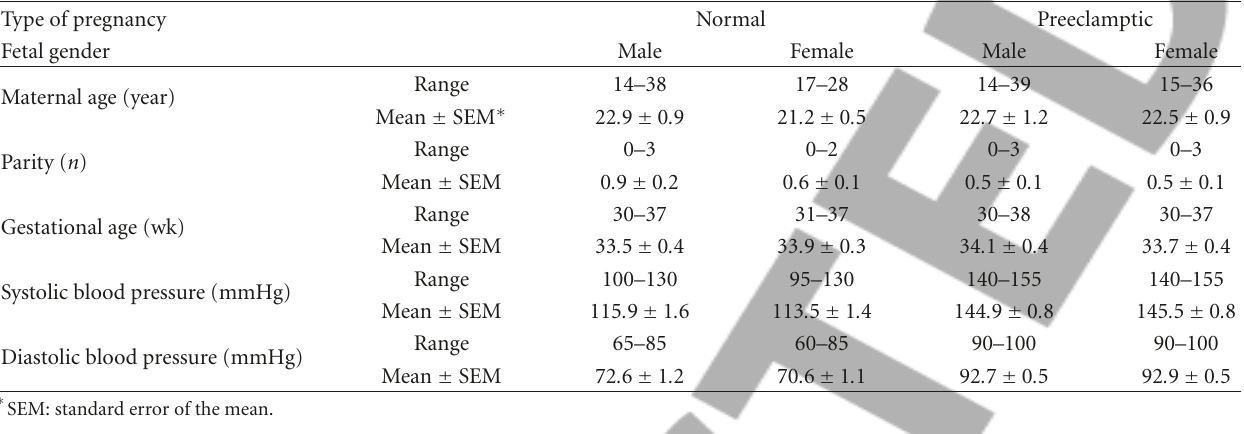
Table 1: Comparison of the clinical characteristics in normal and preeclamptic pregnancies with male and female fetuses. Type of pregnancy